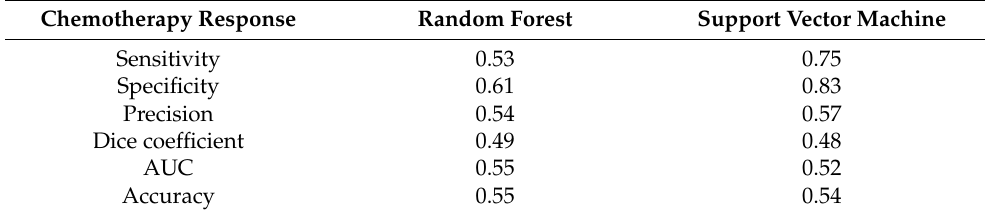
Figure 2. Representative 18 F-FDG PET image of osteosarcoma in a responder and non-responder to neoadjuvant chemotherapy. Responder had SUVmax values of 11.33 and 4.43 at baseline PET0 and after neoadjuvant chemotherapy (PET1), respectively. Non-responder had SUVmax values of 5.62 and 3.21 at baseline PET0 and after neoadjuvant chemotherapy (PET1), respectively. Table 3. Random forest and support vector machine accuracy performed on total image texture features from 105 osteosarcoma patients in baseline